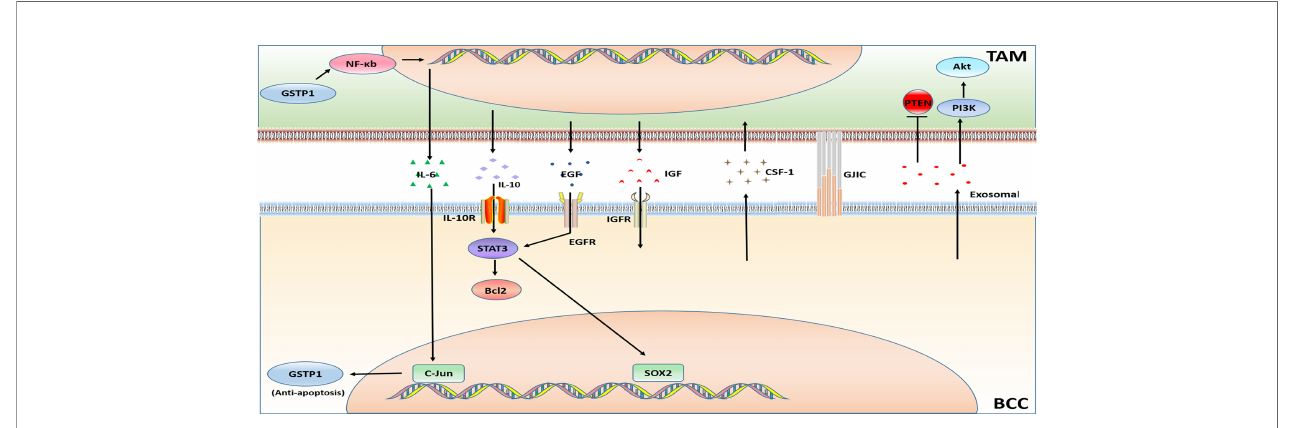
FIGURE 3 | Major mechanisms of chemotherapy resistance in BC in connection with